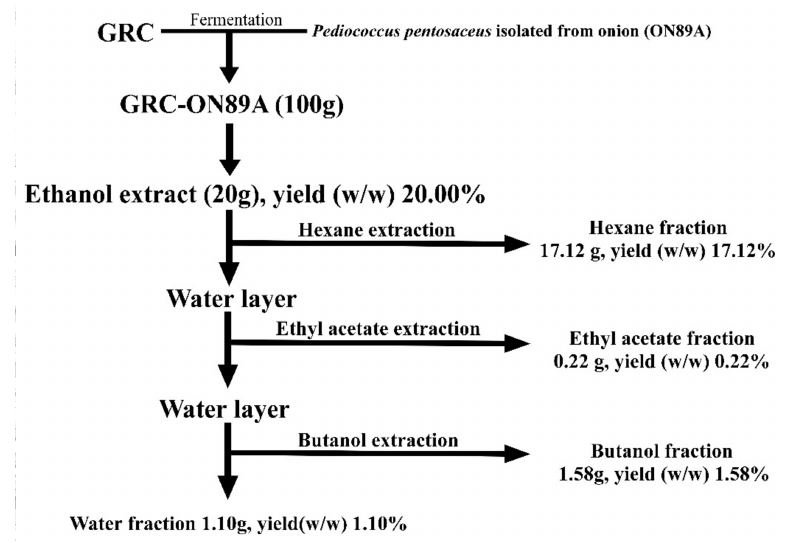
Figure 7. Fractionation of Cordyceps militaris grown on germinated Rhynchosia nulubilis (GRC) fermented with Pediococcus pentosaceus ON89A isolated from onion